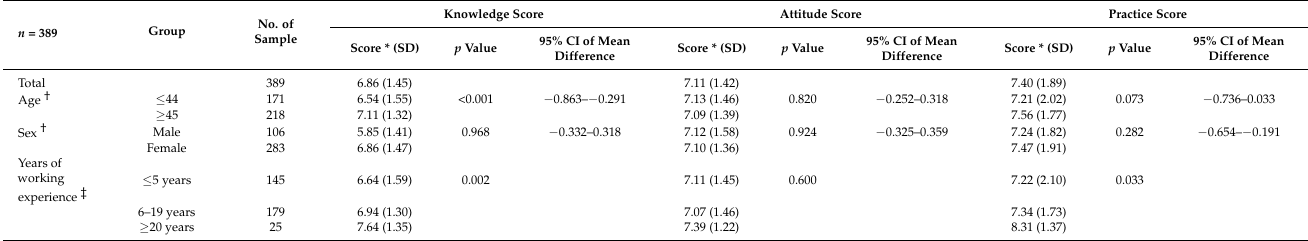
Table 5. Differences in COVID-19-related knowledge, attitudes, and practices scores among nursing care worker demographic